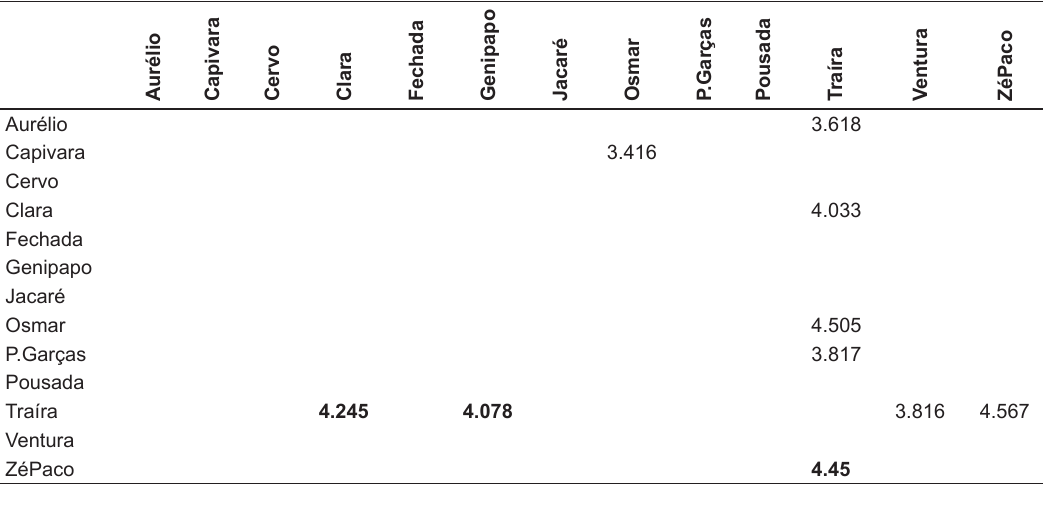
Table 1. Significant results of “z” obtained through analysis of multiple comparisons of the Kruskal Wallis